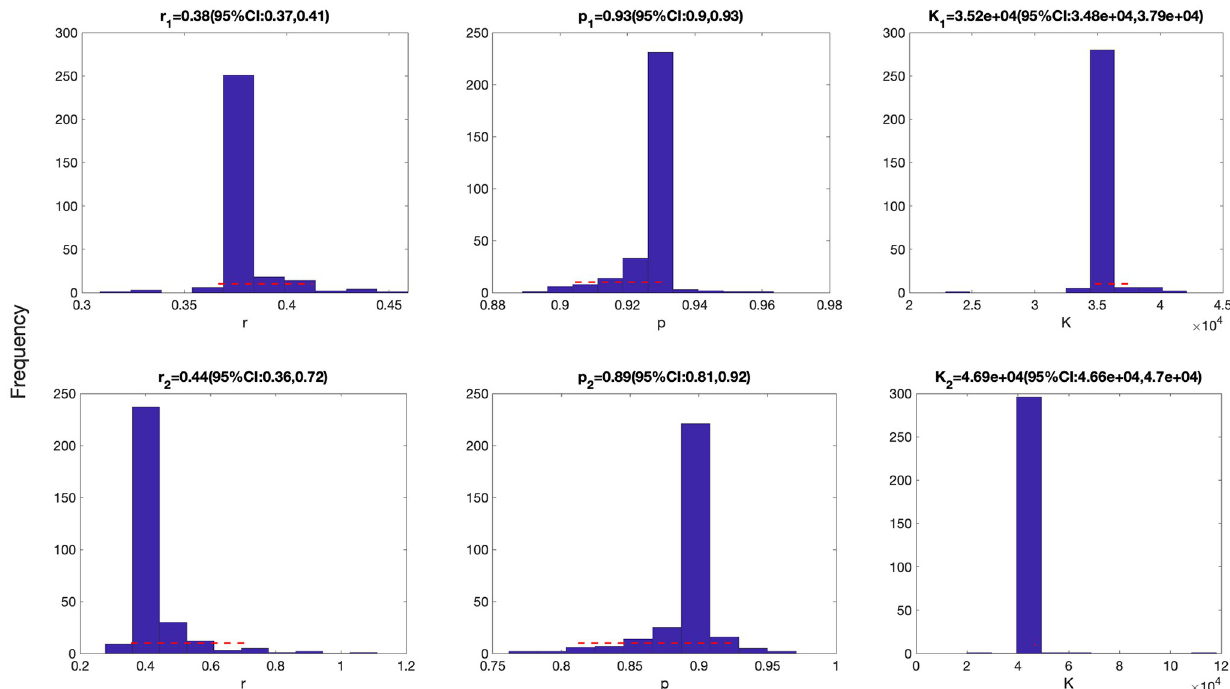
Fig 3. Parameter estimates for the first (top panel) and the second sub-epidemics (bottom panels) were derived for the top-ranking sub-epidemic model after fitting the sub-epidemic modeling framework to the daily curve of COVID-19 deaths in the USA from 27-Feb-2020 to 20-April-2020 (see also Fig 1). Parameter estimates for both sub-epidemics are well identified, as indicated by their relatively narrow bootstrap confidence intervals.